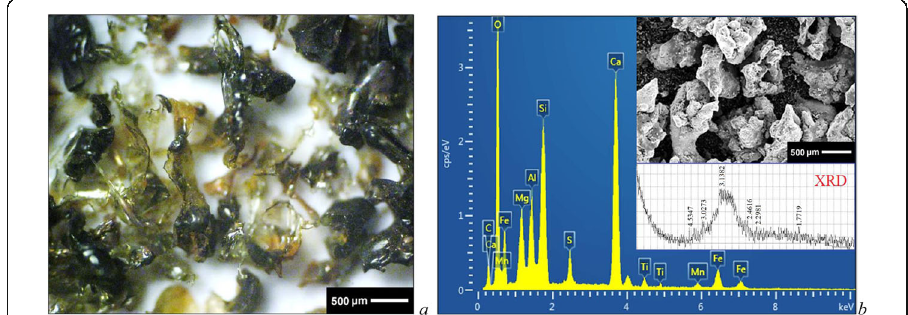
Fig. 3 Morphology ( а ) and EDS and XRD spectrograms of granule ( b ) obtained by the hydro-vacuum granulation of